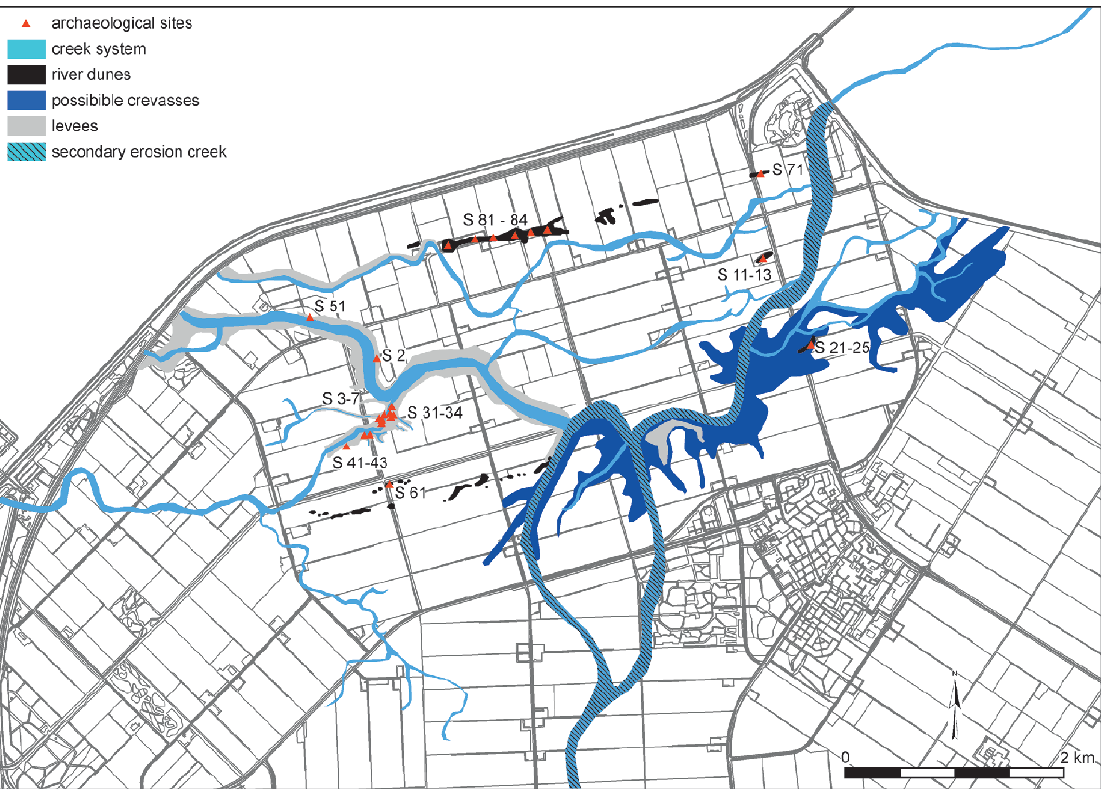
Figure 1. Palaeo-geographic reconstruction of the area around Swifterbant (approximately 4300 BCE) and location of investigated sites. Source: [36], Figure 2.2.